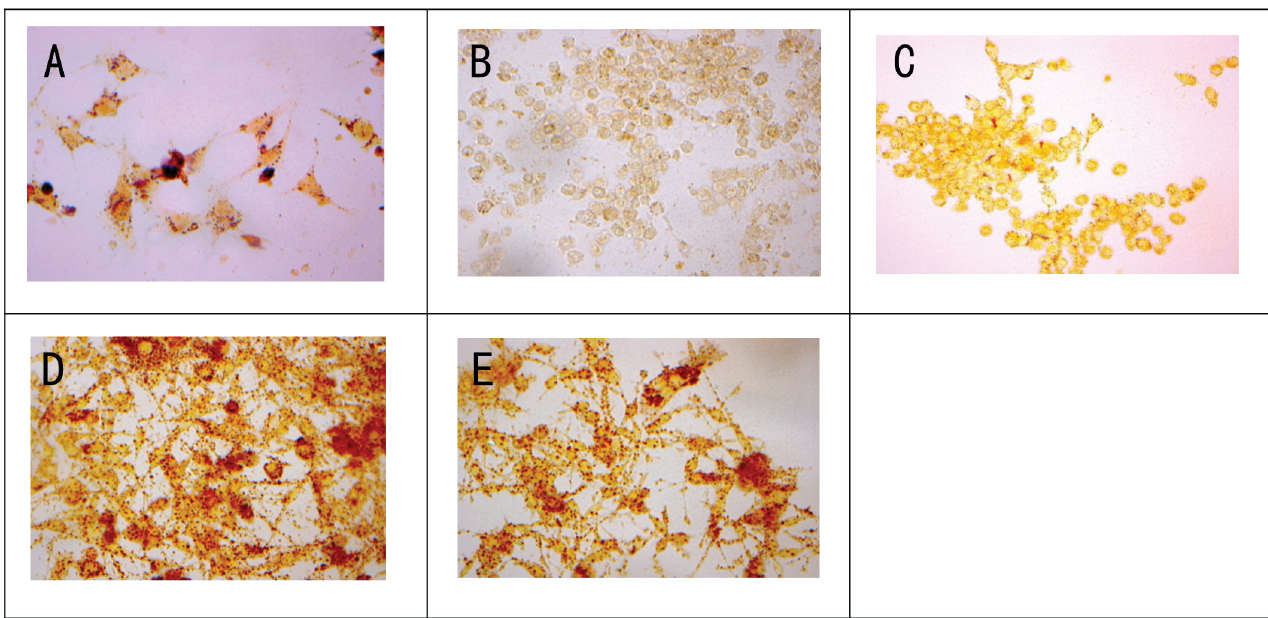
FIGURE 4 - Comparison of mOC between mechanical and inductive procedure by TRAP staining (× 400). (A) Mechanical method for 3 d. (B) Inductive method for 4 d. (C) Inductive method 7 d. (D) Inductive method for 12 d. (E) Inductive method for 15 d.